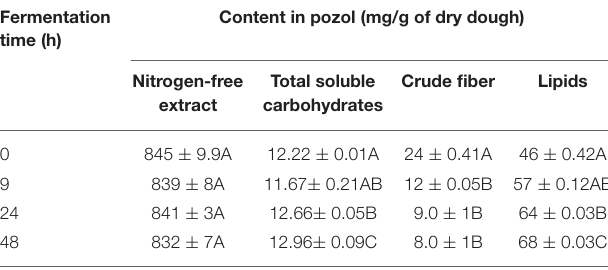
TABLE 1 | Chemical composition of pozol at different fermentation times.